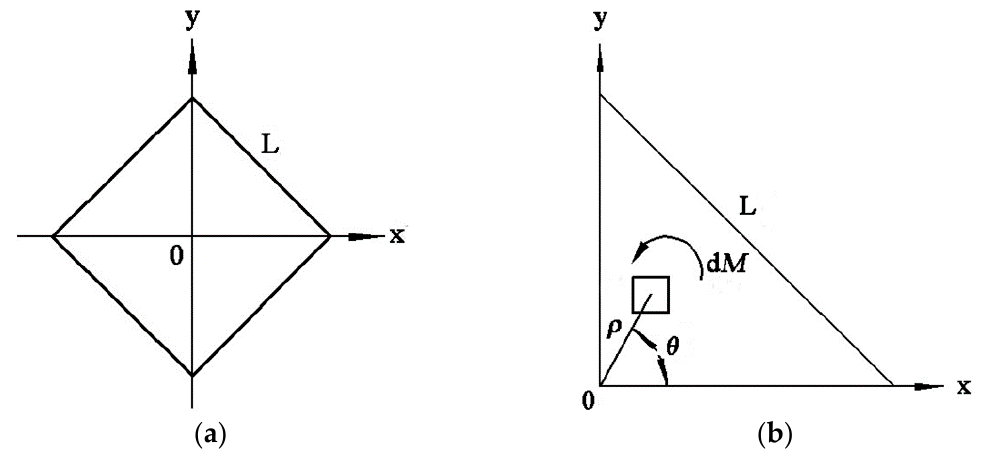
Figure 14. Principle of the analytical model: ( a ) position of the icing sample in the Cartesian coordinates; ( b ) a quarter of the icing sample.